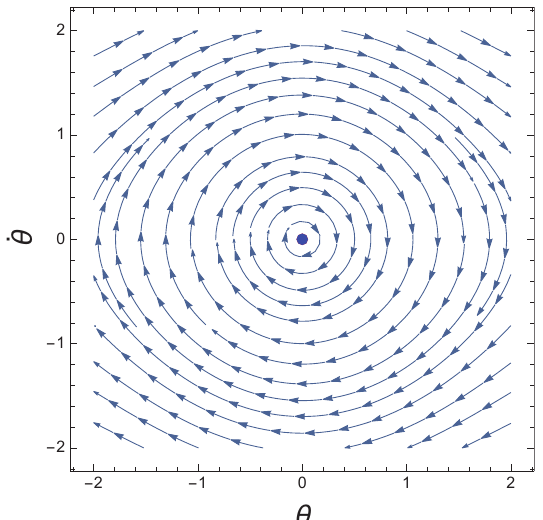
Figure 1. The phase portrait to the dynamical system of the i.v.p. (1) near the equilibrium point ( 0,0 ) is considered for